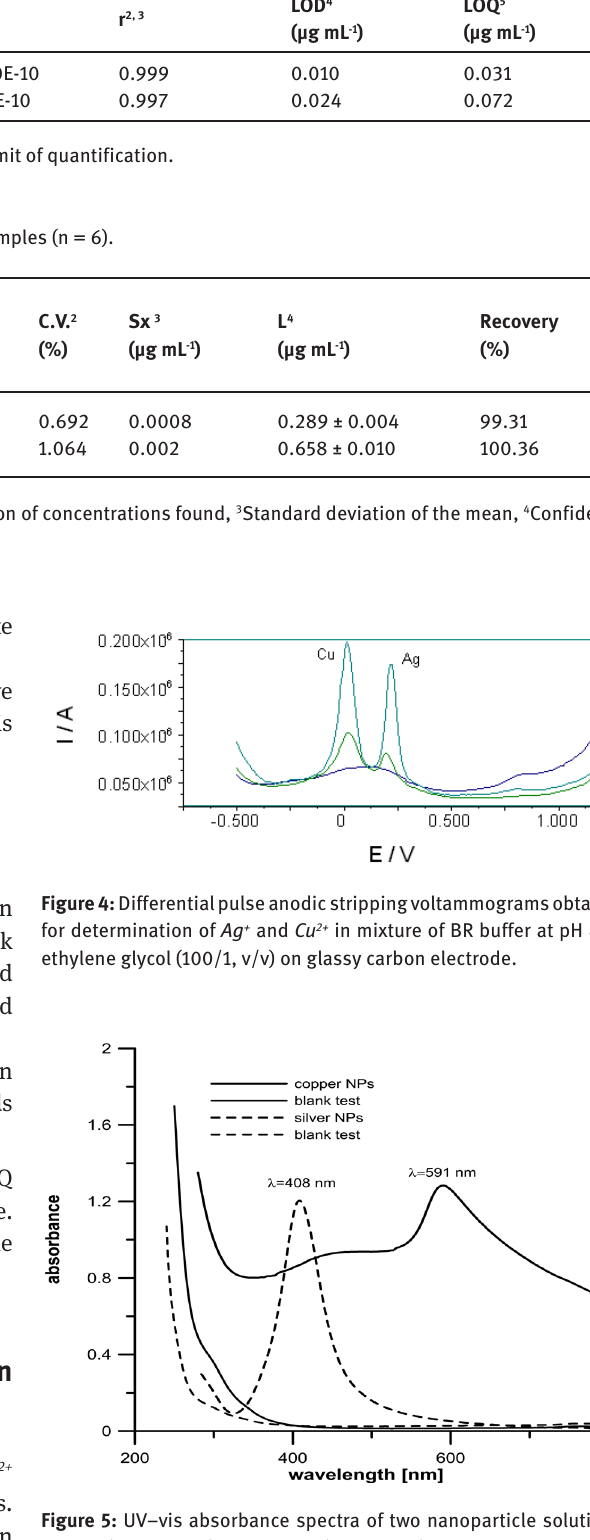
Table 1: Analytical parameters of calibration curves of examined ions in model solutions (n = 6). Linear range Ion